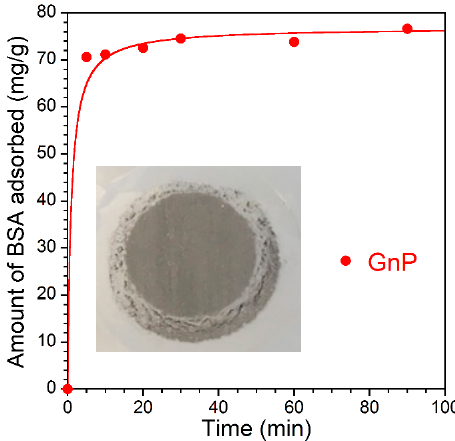
Figure 5. The kinetics of BSA adsorption from PBS on the graphene nanoplatelets (mass loading ~100 mg; initial concentration of BSA 2 mg/mL; liquid phase volume 10 mL). Inside of the Figure is filter paper showing visible small particles post filtration. The experimental data was fitted using the pseudo-second-order kinetic model.